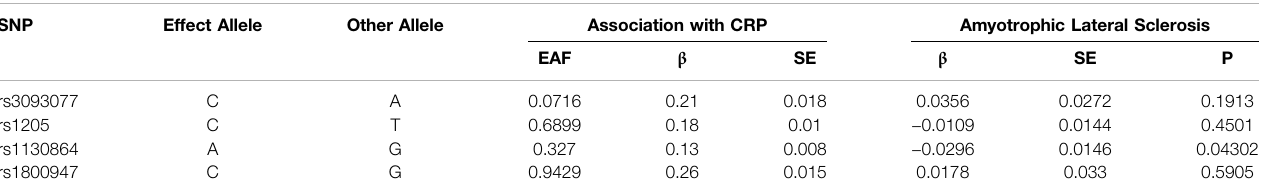
TABLE 1 | The characteristics of the selected conservative CRP instrumental